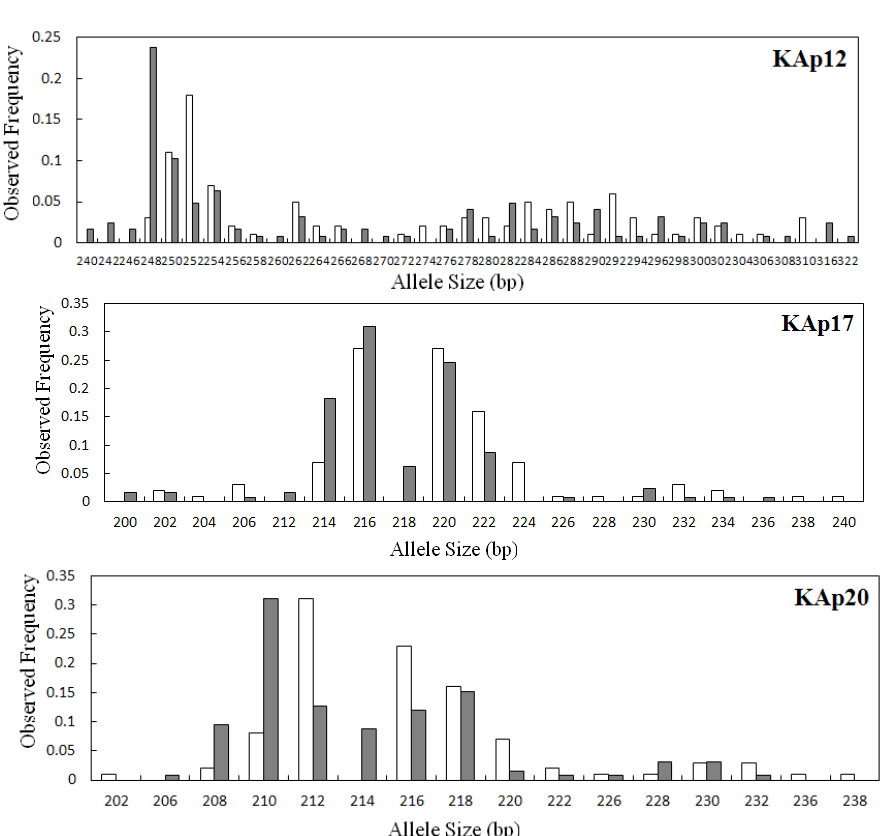
Figure 1. Allele frequency distributions at the eight microsatellite loci which showed significant heterogeneity from the wild (closed box) and hatchery (open box) populations of Atrina pectinata used in this